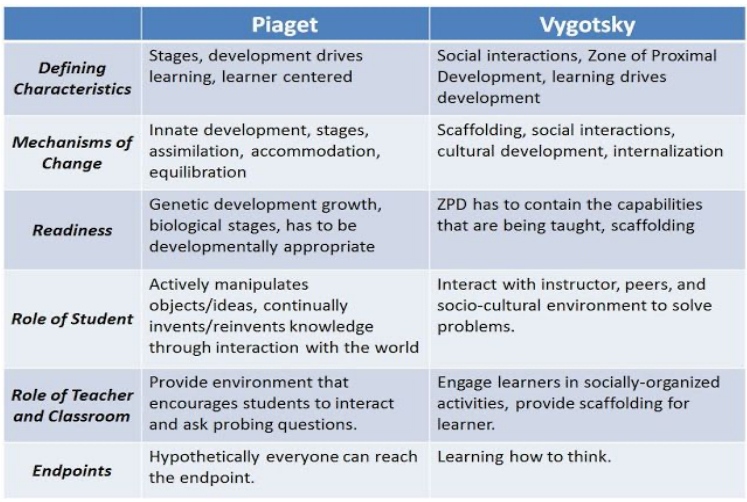
Fig. 2. Comparing the two theories of Piaget & Vygotsky